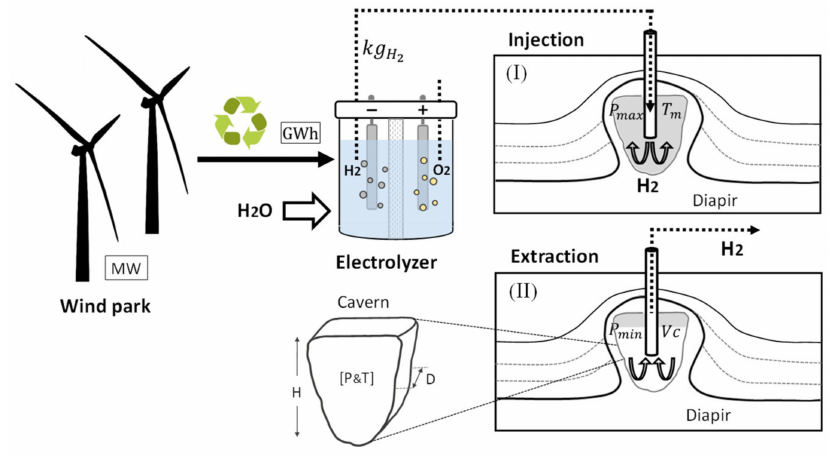
Figure 6. Typical scheme of the process of generation, injection, and extraction of green